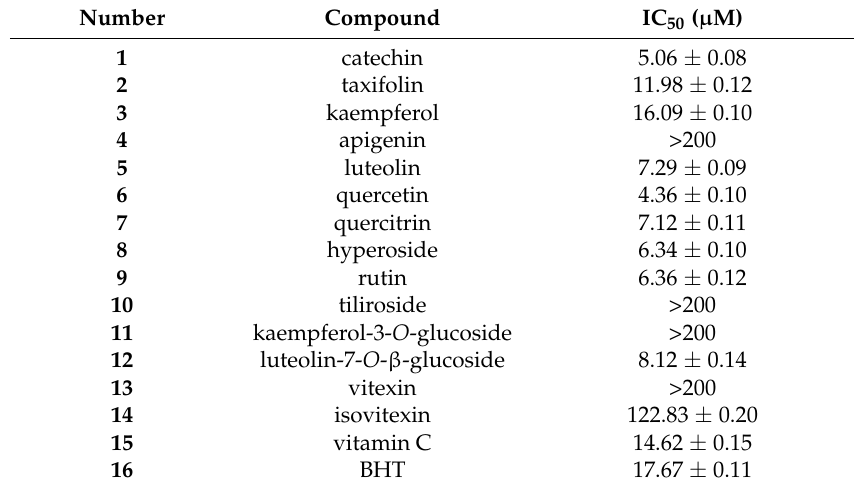
Table 1. DPPH scavenging activity of flavonoids from Agrimonia pilosa Ledeb with IC 50 1,2 ( µ M)